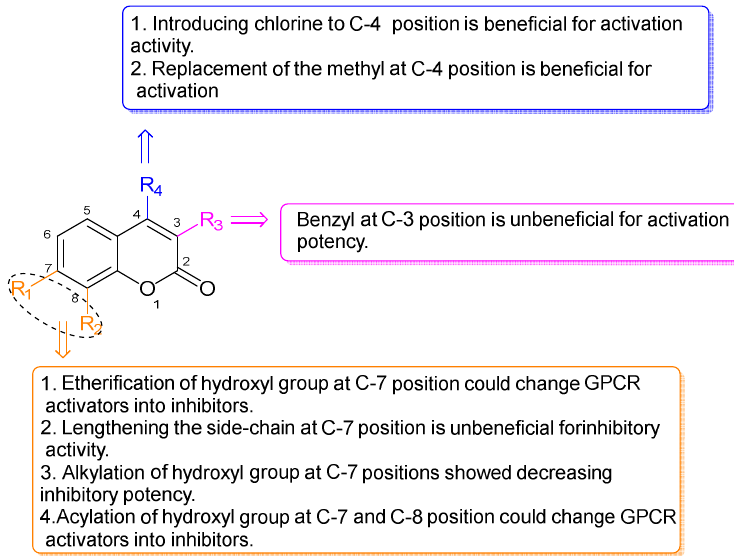
Figure 3. The SARs of coumarin derivatives in GPCR bioactivity.